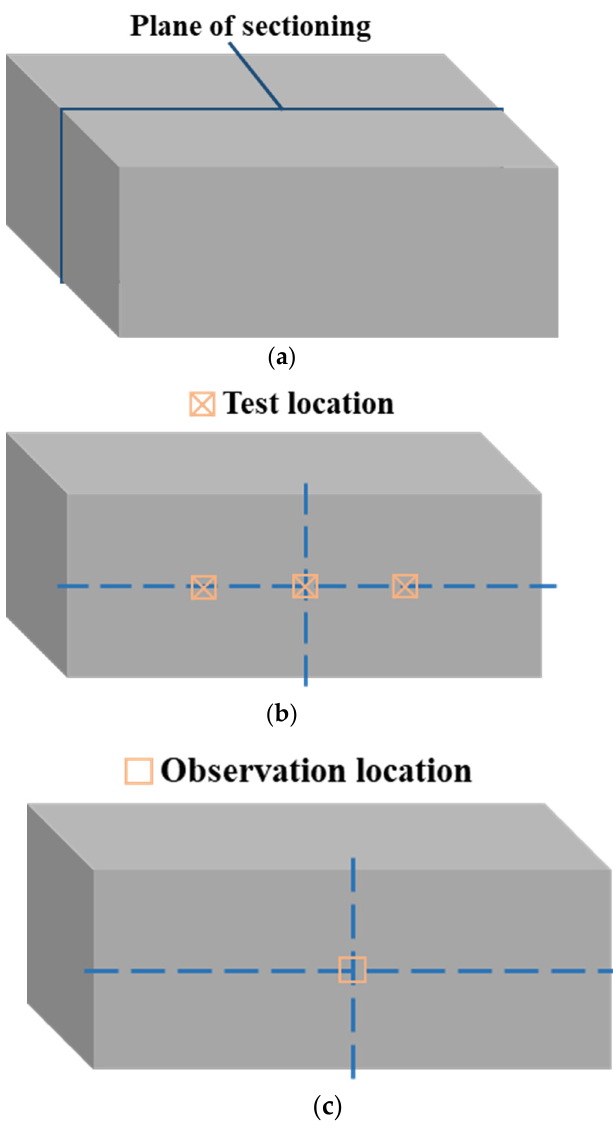
Figure 6. Schematic representation for ( a ) cutting plane of stripe specimen, ( b ) locations for micro- hardness test, and ( c ) locations for microstructure observation.